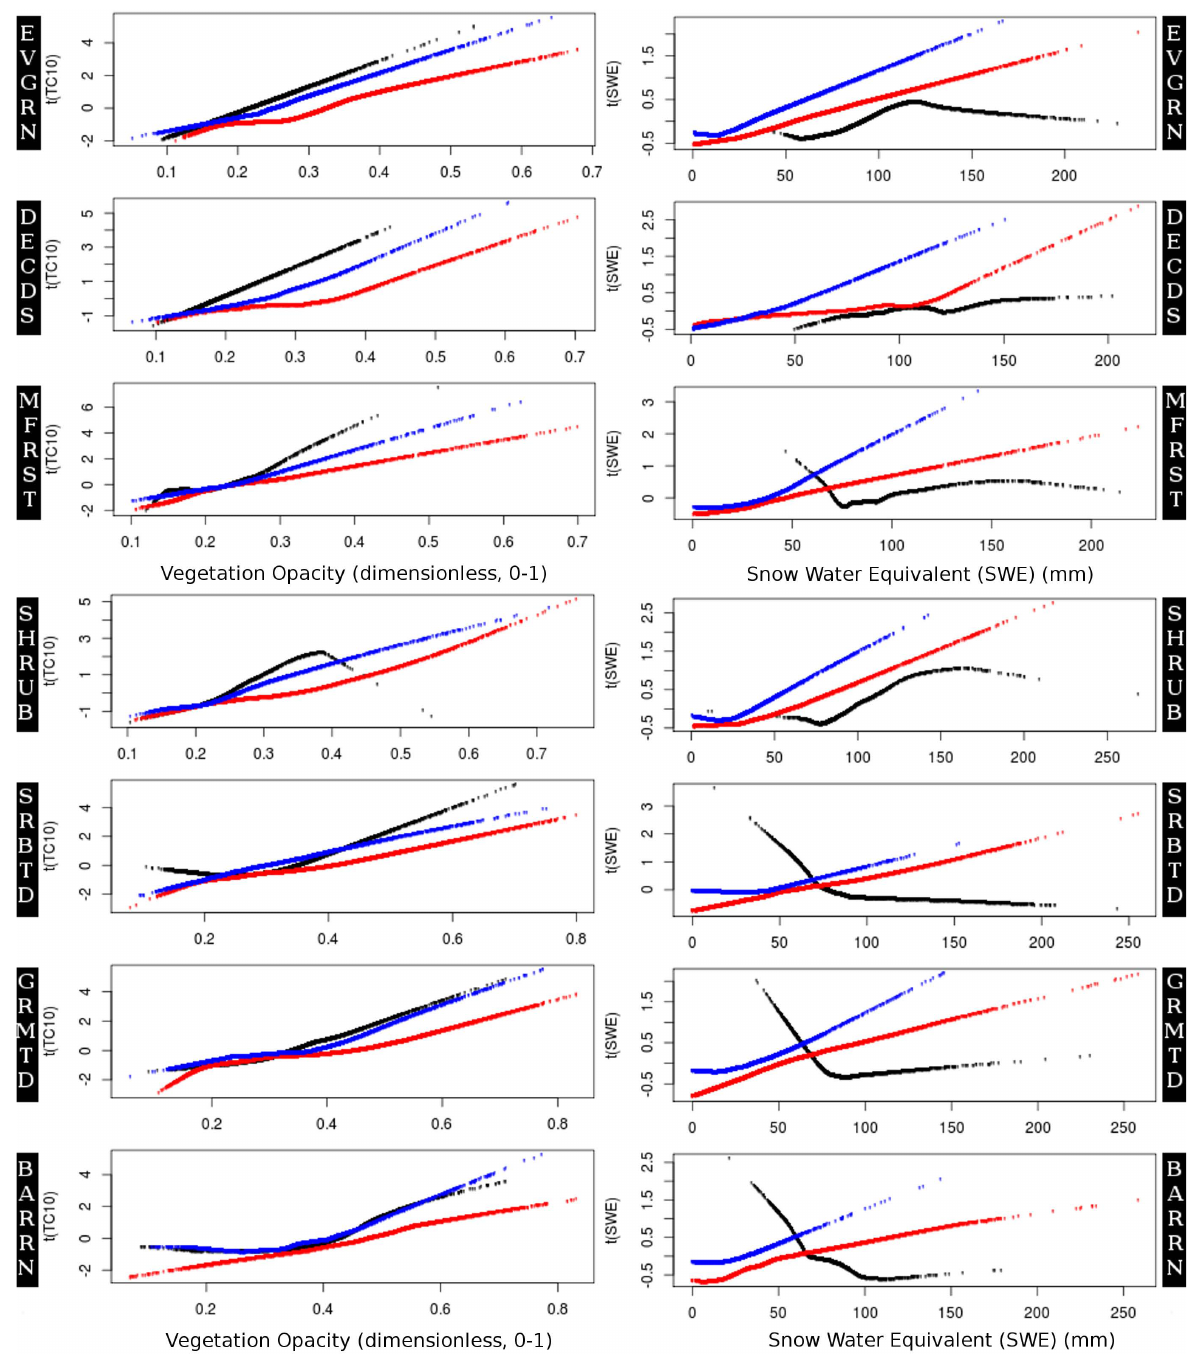
Fig. 6. a–c: Associations between satellite estimates of vegetation transmissivity at 10.7GHz (TC10) and SWE over seven vegetation classes, and three time periods: mean 2003–2008 (black), before and after snowmelt (red), and preceding and following snow onset (blue). Each plot indicates the point pairs [TC10, t (TC10)] and [SWE, t (SWE)] identified using the ACE technique for all forest vegetation classes. d–g: Associations between satellite estimates of vegetation transmissivity at 10.7GHz (TC10) and SWE over seven vegetation classes, and three time periods: mean 2003–2008 (black), before and after snowmelt (red), and preceding and following snow onset (blue). Each plot indicates the point pairs [TC10, t (TC10)] and [SWE, t (SWE)] identified using the ACE technique for all non-forest vegetation